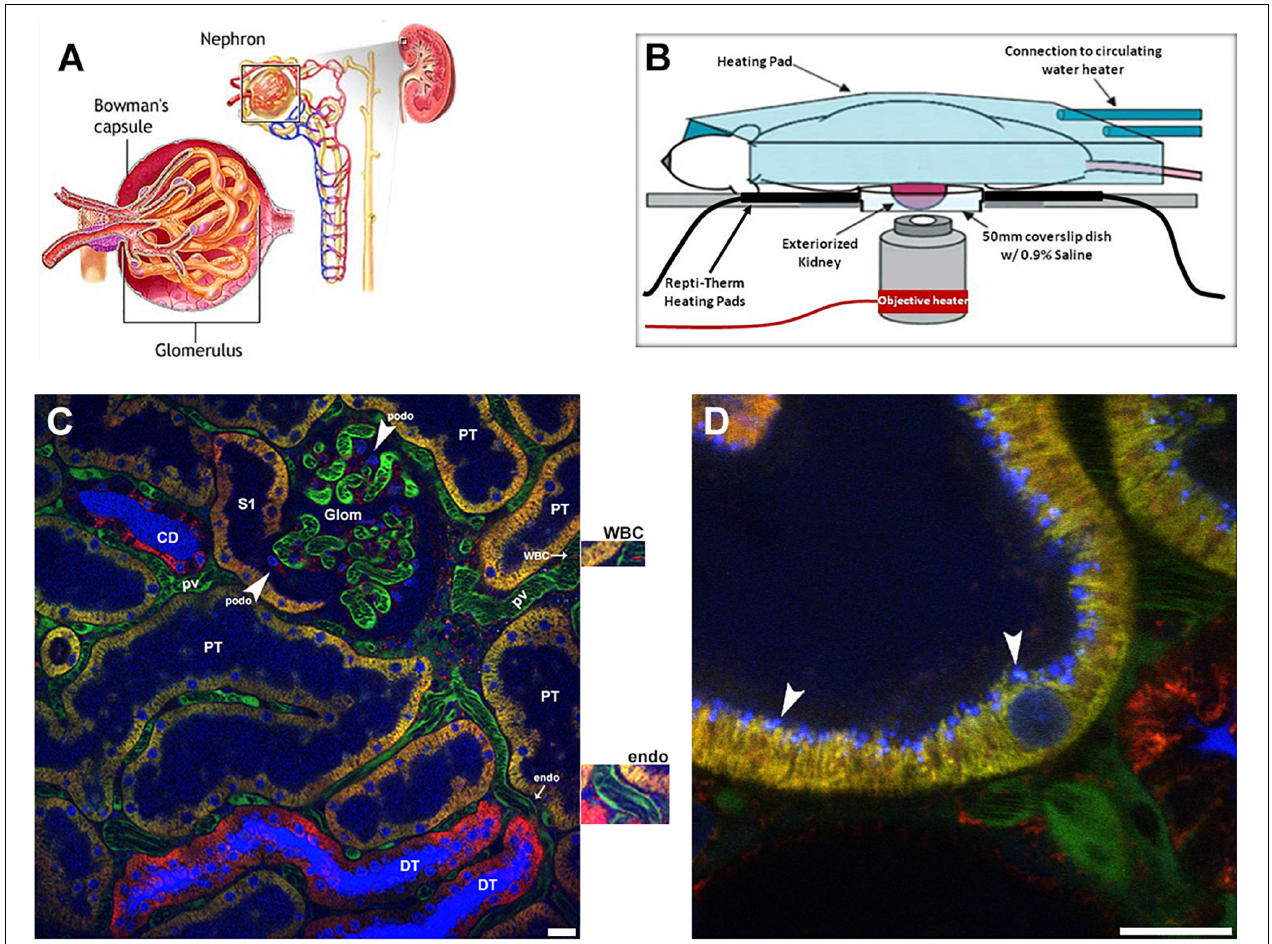
FIGURE 1 | Visual resolving power of intravital multi-photon microscopy: a schematic of the renal architecture to subcellular resolution in proximal tubules. (A) Shows a classic diagram of the kidney in cross-section (upper right), with an inset of the complete nephron (center), and glomerulus (left). (B) Shows a schematic of the set-up used for 2-photon imaging. Placing the left exteriorized kidney onto a coverslip bottom dish on an inverted microscope is the most efficient way to minimize motion artifact from breathing. The various heating elements shown are used to maintain the proper kidney and body temperature, which is monitored and regulated. (C) Shows a single plane cross section with a glomerulus (glom) in the upper center and surrounding peritubular vasculature made visible using a large 150 kDa FITC dextran (green) retained in the plasma. Faint blue fluorescence in proximal tubule lumens (PT) and intense blue fluorescence in the lumen of collecting ducts (CD) and distal tubules (DT) comes from a small rapidly filtered 10 kDa Cascade Blue dextran bolus administered earlier. In DT and CD segments water removal concentrates the dextran intensifying the color. Three different mitochondrial dyes are seen in this image. Rhodamine 123 (yellow) predominantly labels the mitochondria of proximal tubule cells (PT); the open S1 PT segment is seen juxtapose to the glomerulus on the left. Tetramethylrhodamine methyl ester (TMRM, red) predominantly labels mitochondria in the distal tubules (DT) and collecting ducts (CD). Note the heterogenous labeling seen in the collecting ducts between the intercalated and principal cells. Finally, rhodamine B hexyl ester (also red) labels circulating white blood cells (WBC), podocytes (podo) in the glomerulus, endothelial cells (endo) see surrounding the peritubular vasculature, and a variety of cells in the interstitial space. Enlargements for the white blood cell and endothelial cell staining with rhodamine B hexyl ester are immediately adjacent to the right of the image. Hoechst 33342 labels the nuclei of all cell types (blue-cyan) in this micrograph (Bar = 20 µ m). (D) Shows a high magnification micrograph of a shallow 5 µ m, 3D reconstruction of proximal tubule from the same series in (C) . Endocytosis of the 10 kDa Cascade Blue dextran by the proximal tubule is seen accumulating at the sub-apical space in discrete blue vesicles (arrowheads). Note the various sizes of endosomes the microscope can resolve (Bar = 20 µ